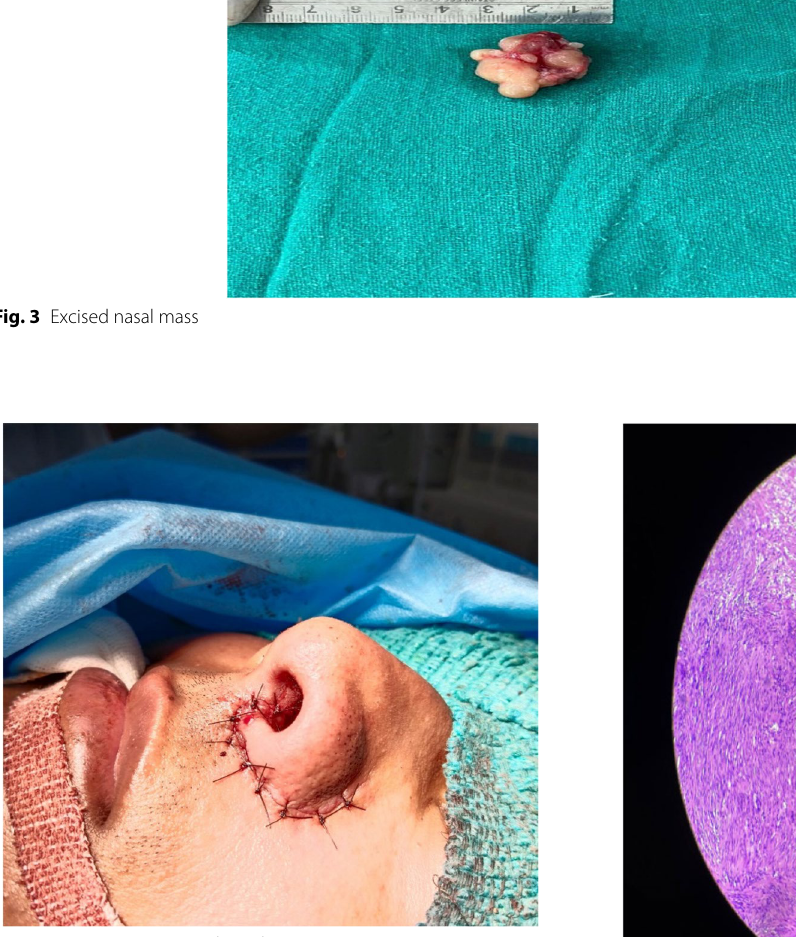
of the trigeminal nerve (ophthalmic/maxillary divisions),